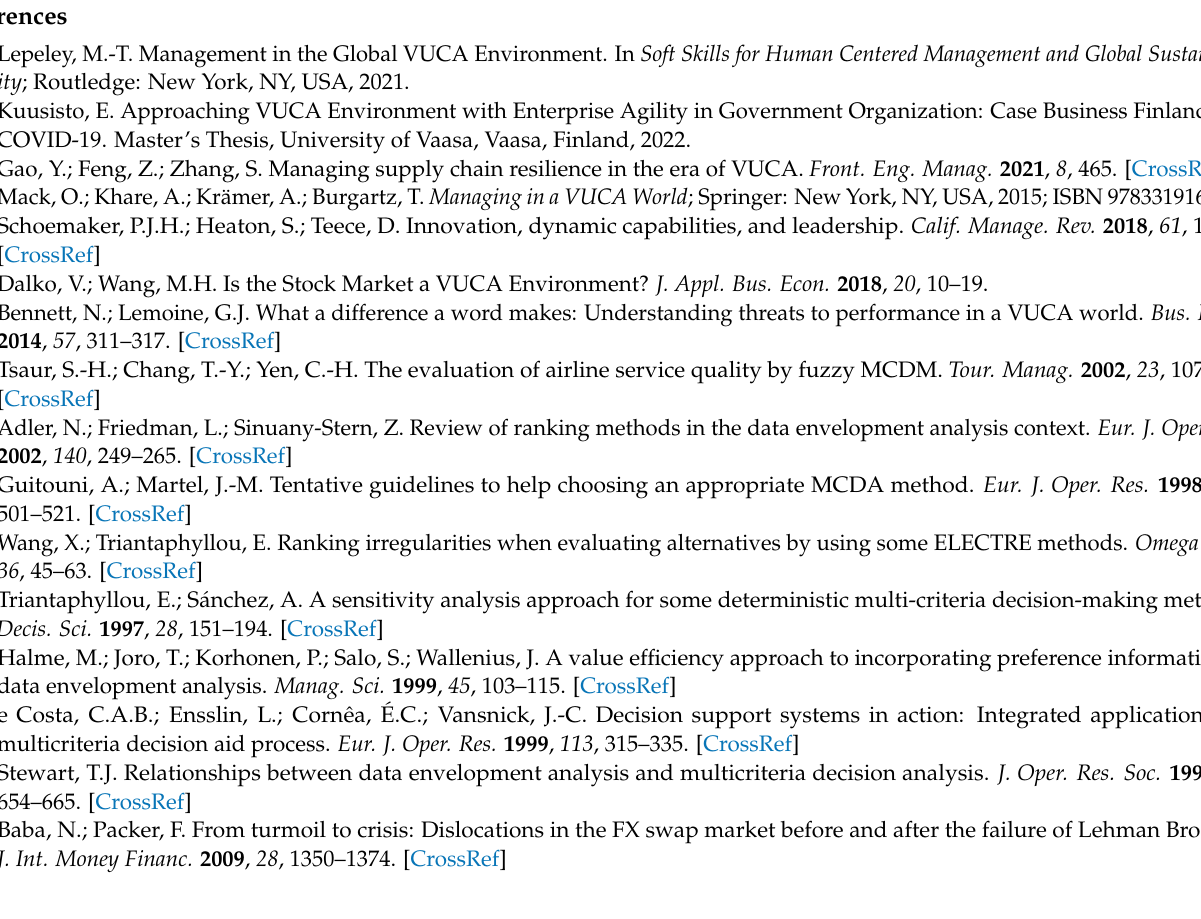
Figure A11. Additive-value-function cluster network.